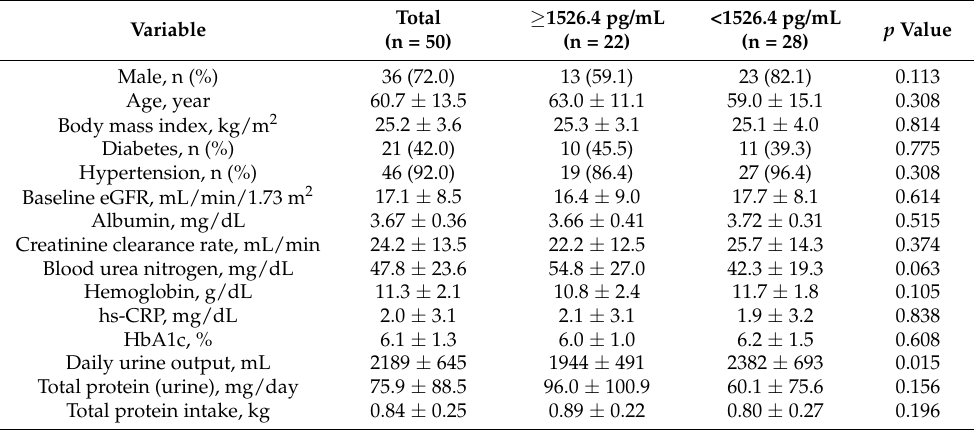
Table 1. Baseline characteristics of advanced CKD patients stratified by the optimal cutoff level of serum DKK1 (1526.4 pg/mL).